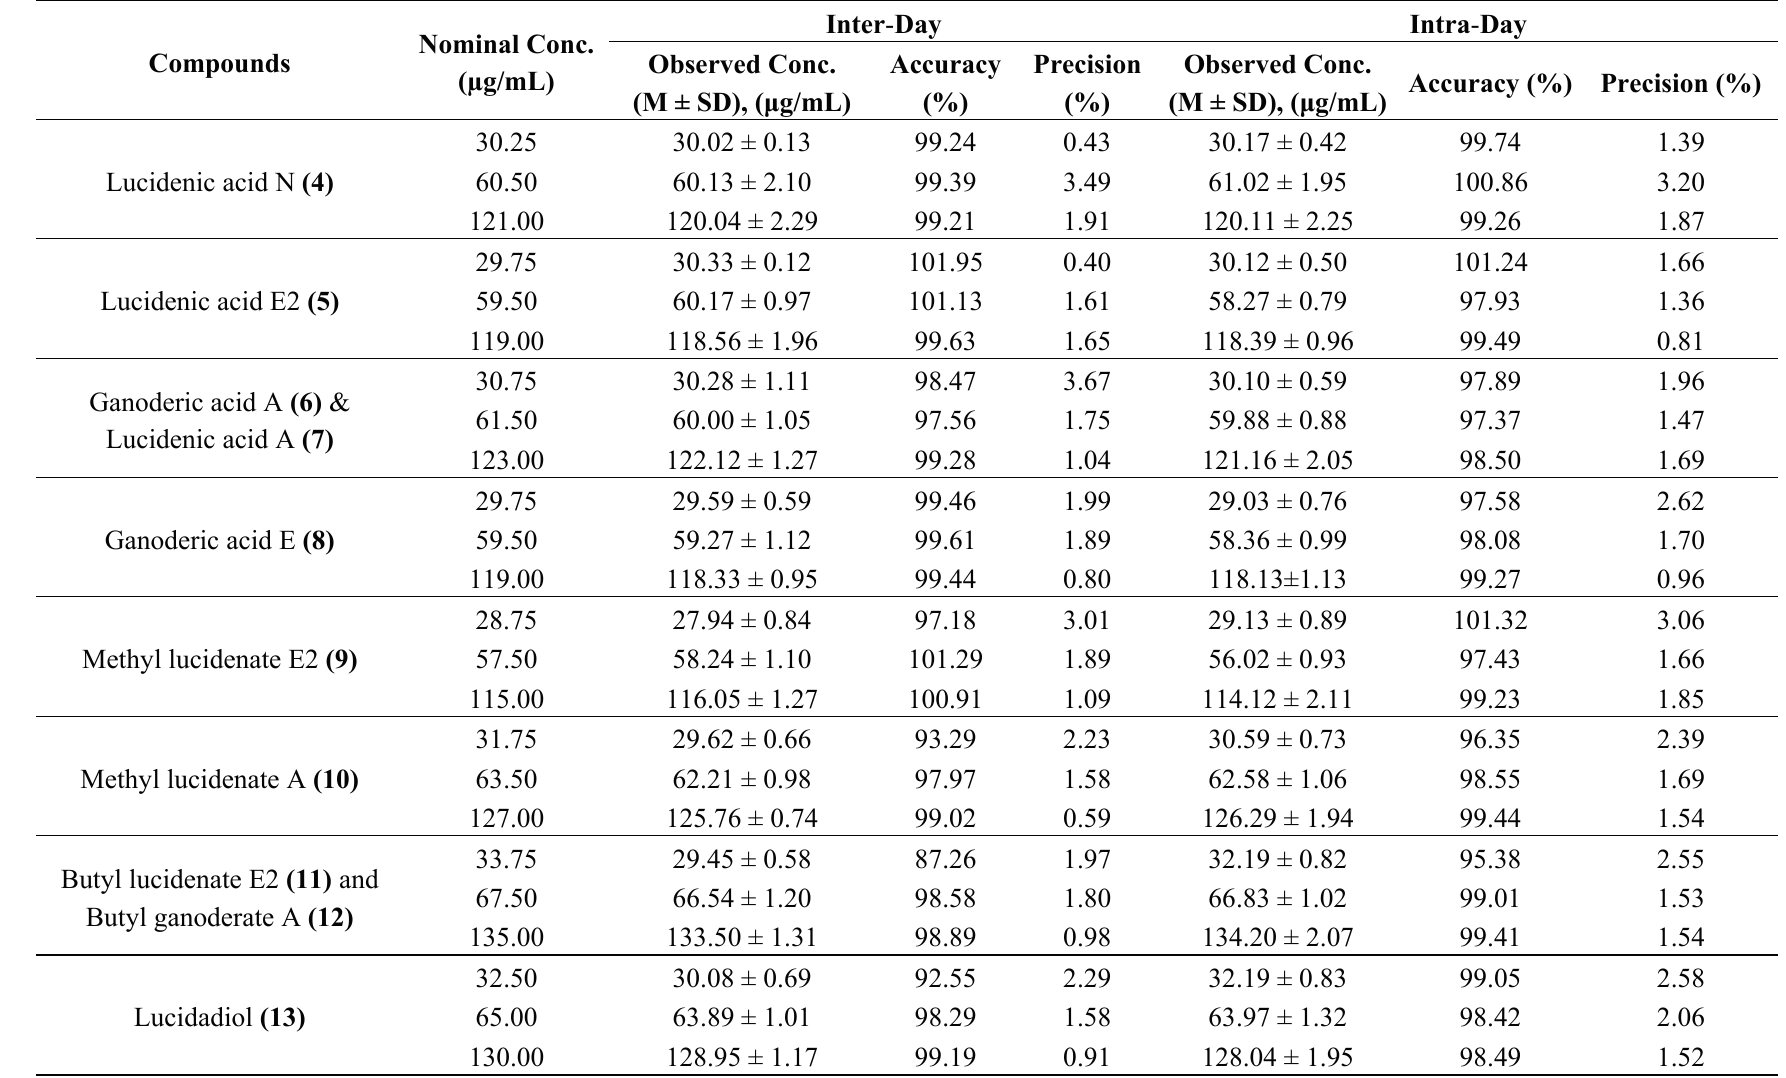
Table 3. Intraday and interday repeatability of 4 – 17